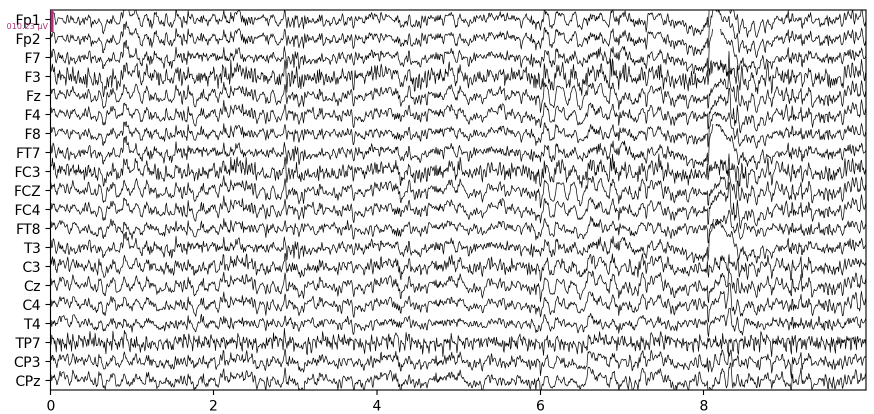
Figure 2. Raw EEG signals recorded on various